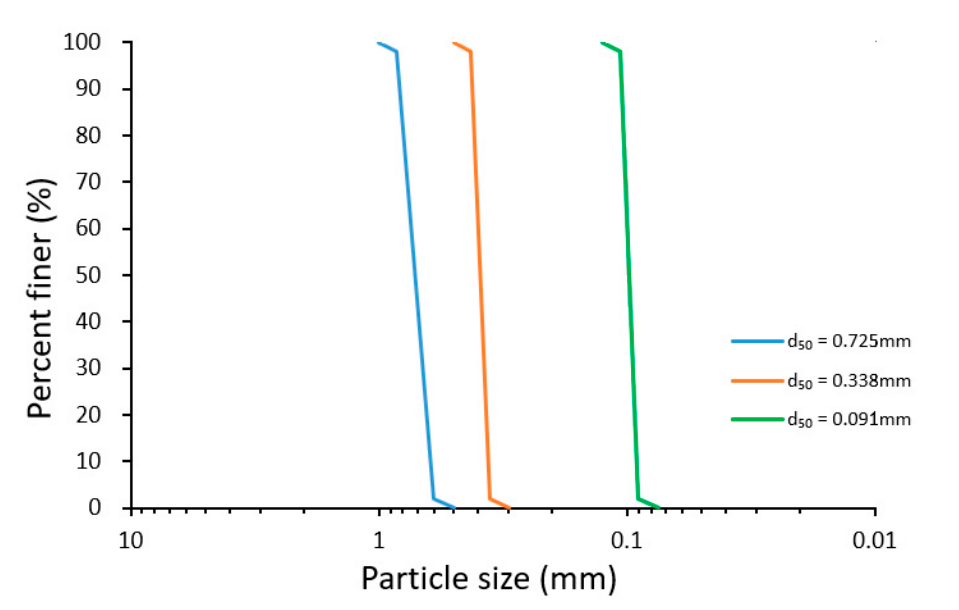
Figure 2. Particle size distribution of the sands. Table 1. Physical properties of sand